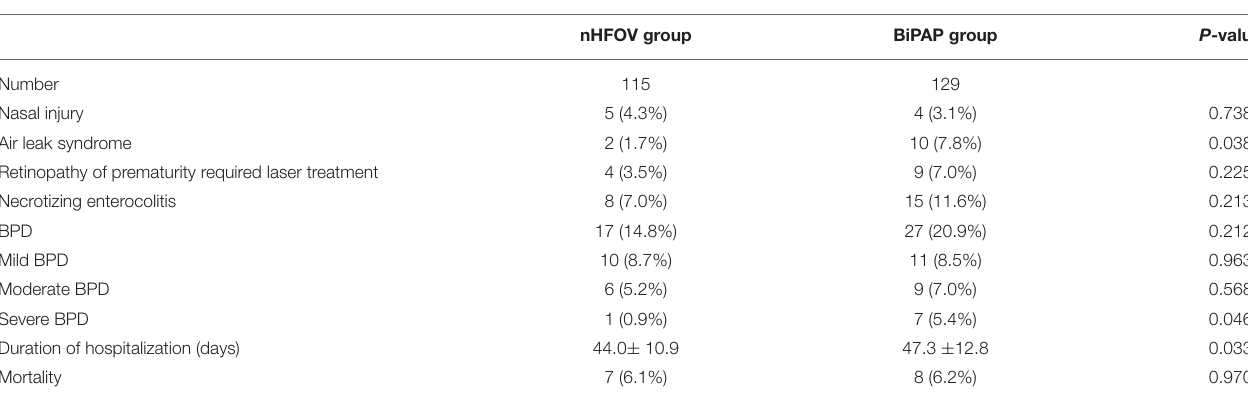
TABLE 3 | Comparison of complications between the two